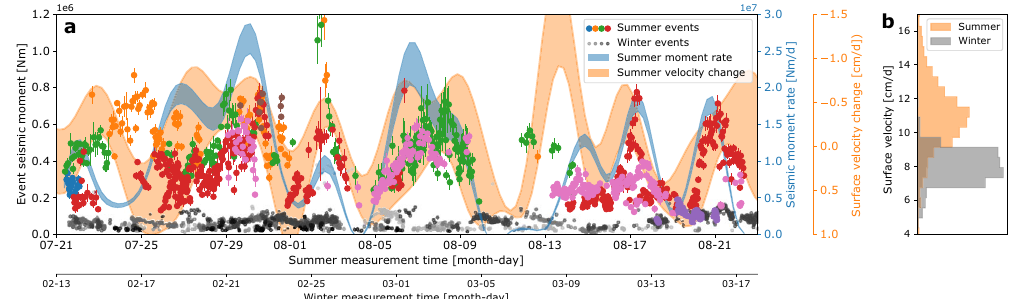
Figure 3. Stick–slip activity time series. ( a ) Time series of stick–slip events for the summer (different color dots) and winter measurement periods (gray dots with time scale on the bottom). Blue area indicates the released seismic moment for the summer events with 1 σ uncertainty. Yellow area indicates the measured surface velocity during the summer measurement period with 1 σ uncertainty. ( b ) Normalized histogram of surface velocity measurements during summer and winter. The difference is attributed to basal